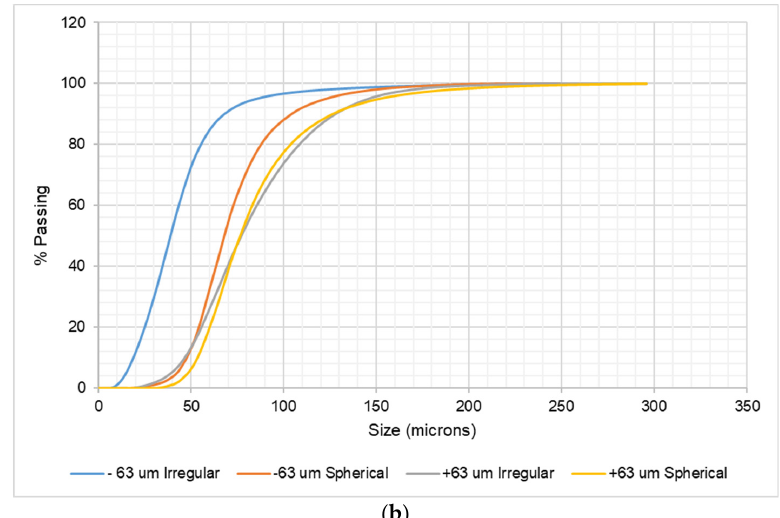
Figure 8. ( a ) The frequency and ( b ) cumulative distribution curves for AISI 304 SS irregular and spheroidised powder.